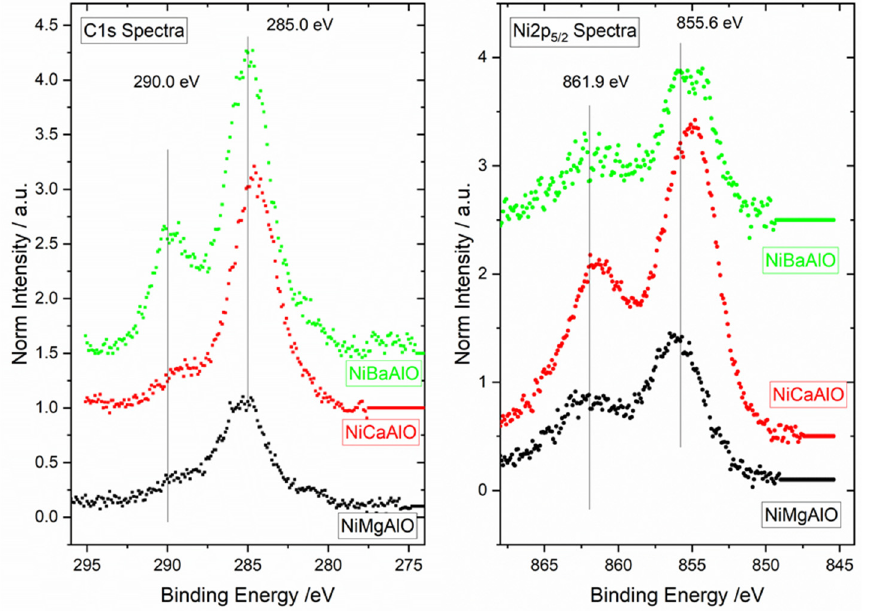
Figure 5. XPS spectra corresponding to the Ni2p 3/2 C1s and O1s regions of the NiBaAlO, NiMgAlO, and NiCaAlO calcined samples. Table 3. Calculated surface % area obtained from XPS and peaks maxima for NiBaAlO, NiMgAlO, and NiCaAlO samples.